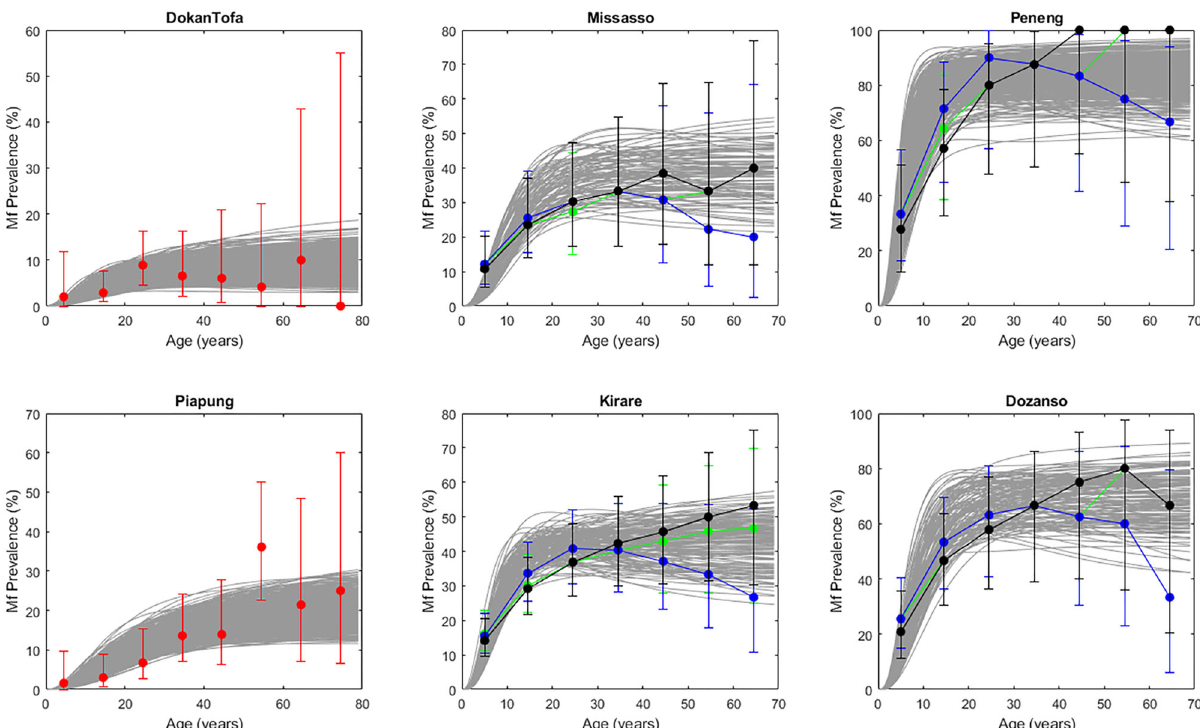
Fig. 1 The SIR BM-based model fi ts to mf prevalence baseline data for two low-prevalence sites (DokanTofa and Piapung), two medium-prevalence sites (Missasso and Kirare), and two high-prevalence sites (Peneng and Dozanso). Red circles indicate the observed age-prevalence data in the case of Dokan Tofa and Piapung, whereas age-strati fi ed prevalence data derived from observed overall community baseline prevalences are shown for linear, plateau and convex age patterns of LF infection by the black, green, and blue curves, respectively, in Missasso, Kirare, Peneng, and Dozanso. Gray lines depict the model predictions for each site. The age-strati fi ed and overall Monte Carlo p-values for the fi ts to baseline infection data for each of the six study sites were evaluated and are provided in Supplementary Table 3 in Supplementary Information. These show that apart from Piapung and Kirare, good fi ts were obtained for all other villages. Error bars indicate the 95% con fi dence intervals for each data